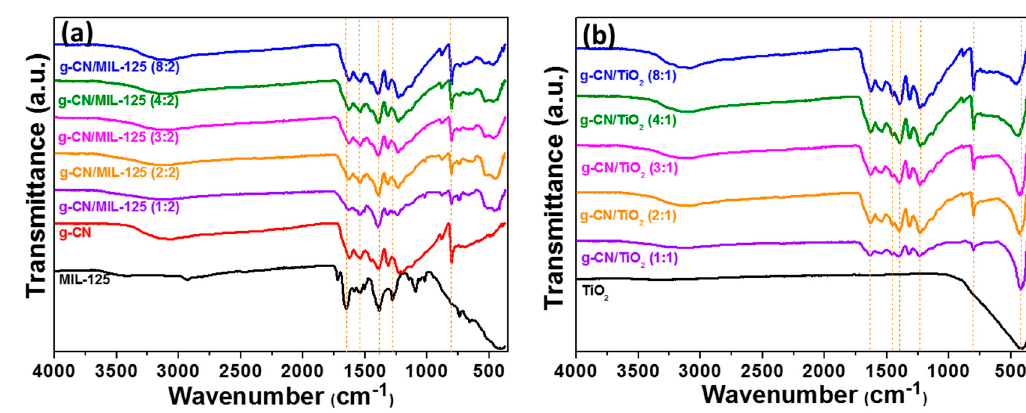
Figure 3. Fourier transform infrared (FT-IR) spectra of ( a ) MIL-125(Ti), g-CN, and of g-CN / MIL-125(Ti) composites and ( b ) TiO 2 and g-CN / TiO 2 composites.